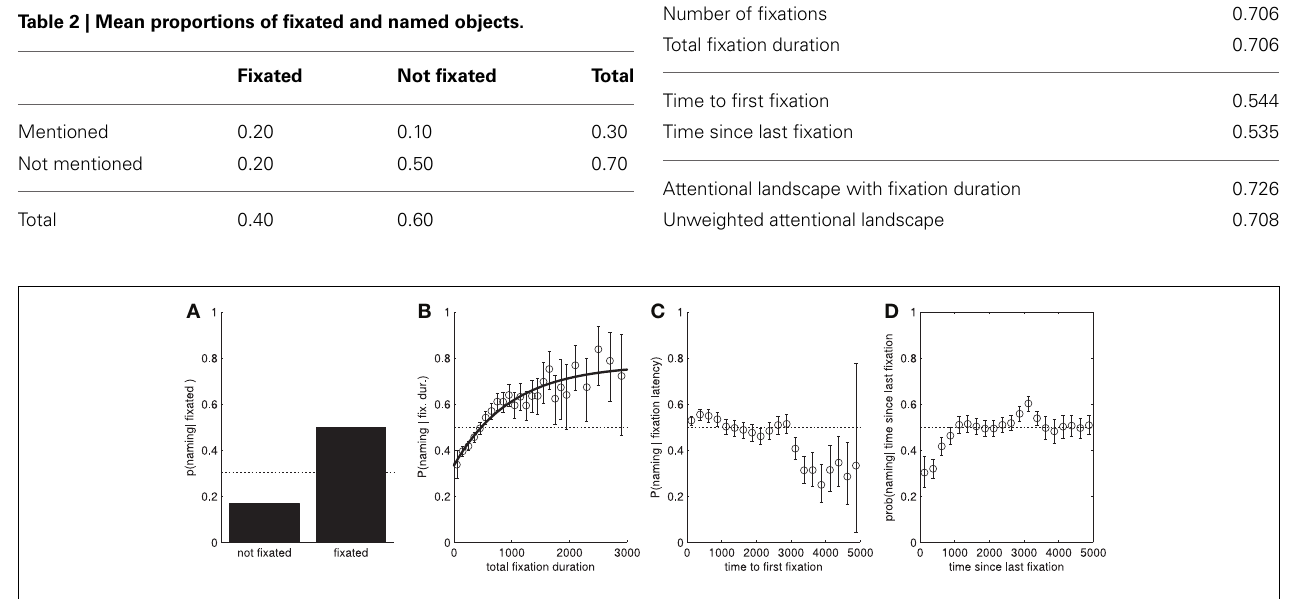
FIGURE 2 | Conditional probabilities of naming an object given attentional features. In all cases, the dotted line shows the baseline probability of naming an object, independent of the x -axis. (A) P (named | fixated ) . We can clearly see that if a participant fixates within an object’s area of interest, then they are much more likely to